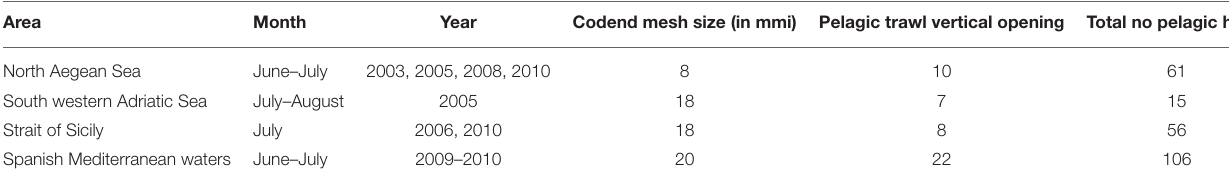
TABLE 1 | Summarized information on pelagic haul data from acoustic surveys.